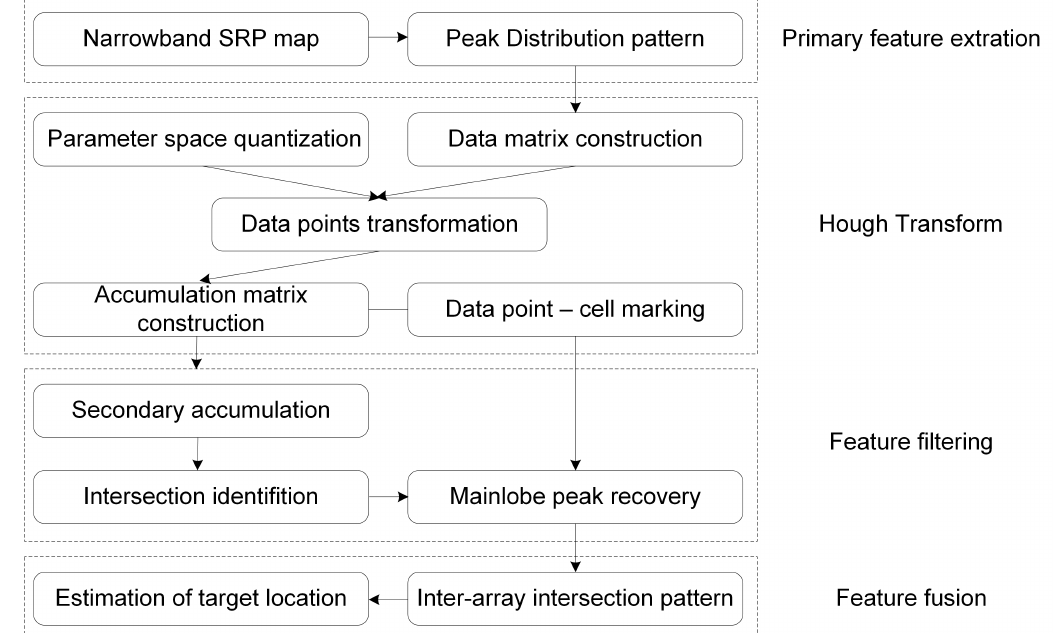
Figure 2. Flow chart of the proposed